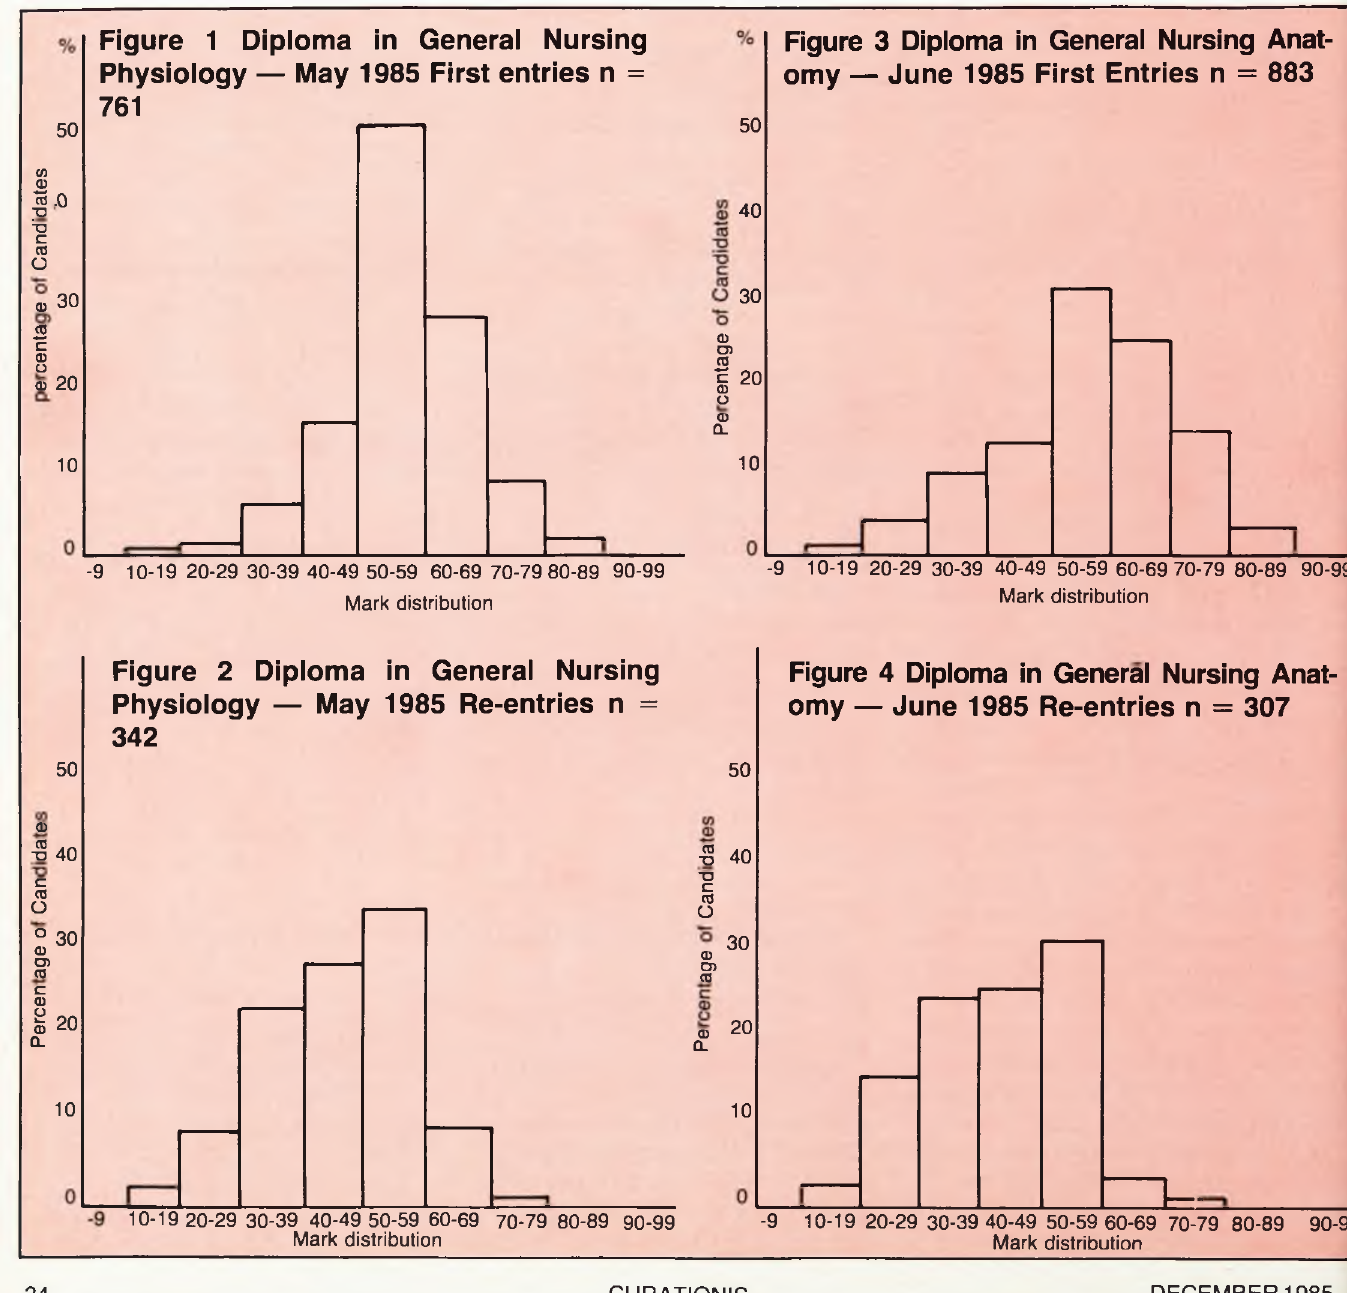
Figure 4 Diploma in General Nursing Anat­ omy — June 1985 Re-entries n =